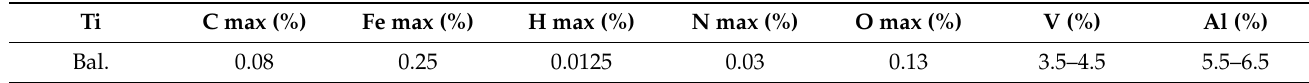
Table 2. Chemical composition of Ti-6Al-4V ELI.